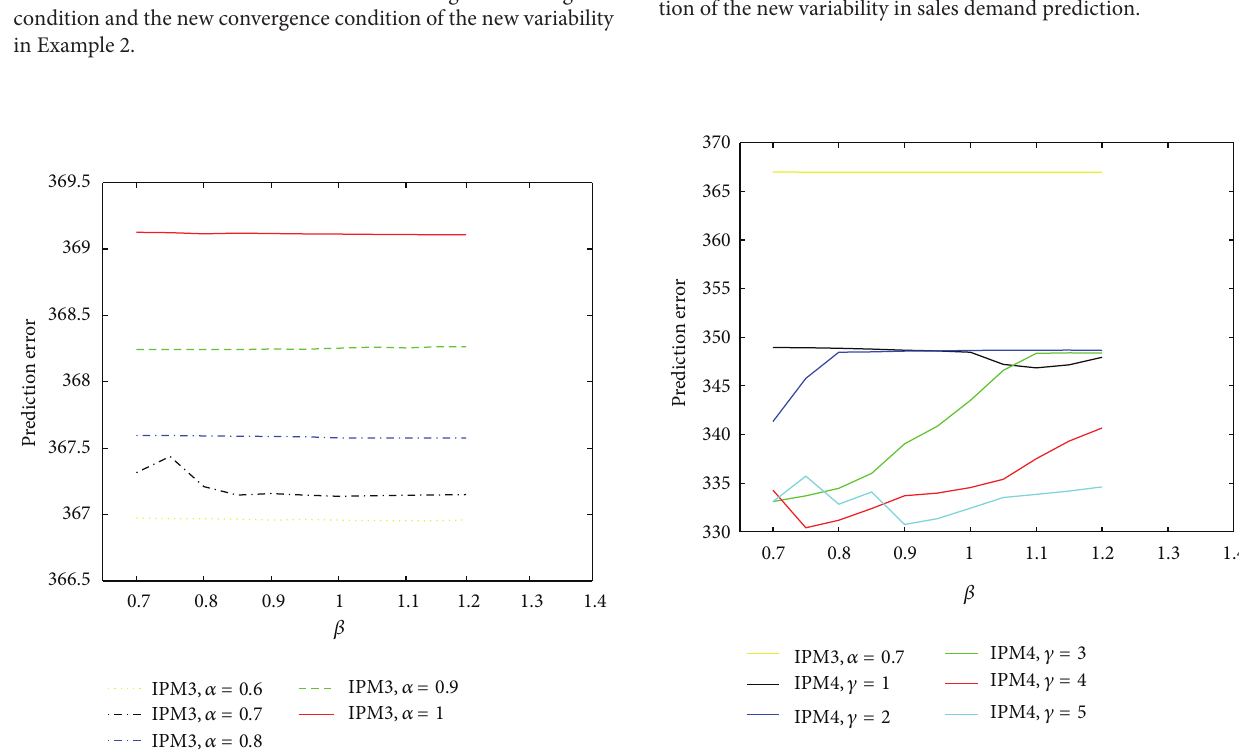
Figure 4: The prediction errors of the new improved parsimonious multivariate Markov chain model with the new convergence condi- tion of the new variability in sales demand prediction.